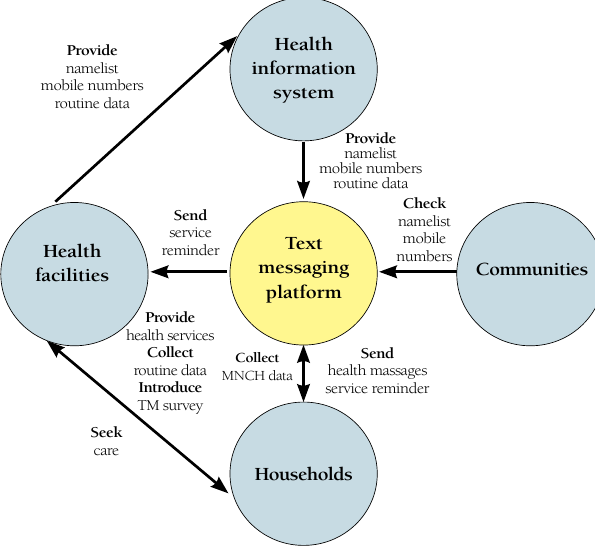
Figure 1. Roles and relationship of different partners in the